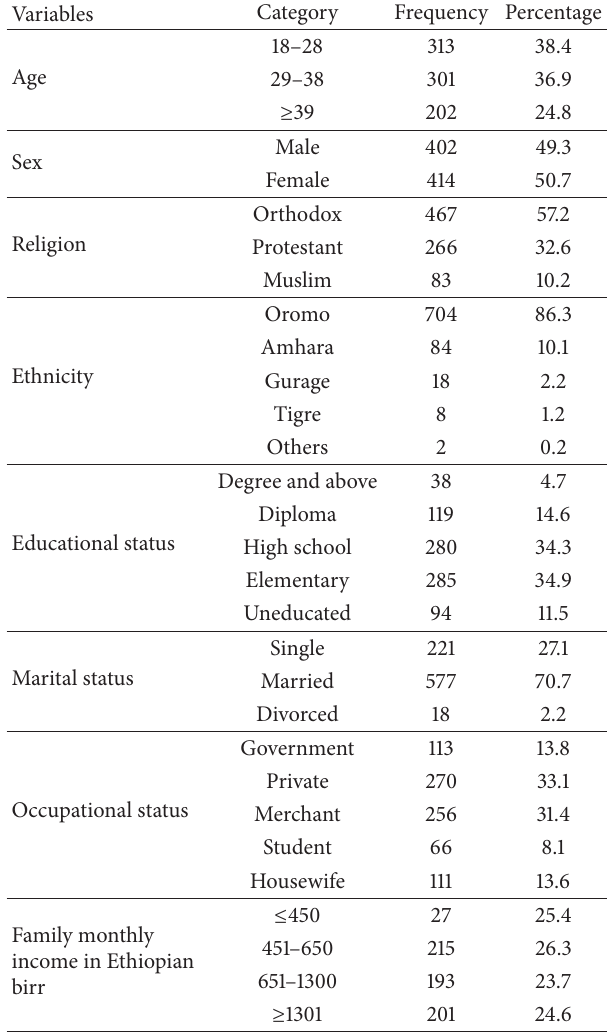
Table 1: Sociodemographic characteristics of respondents ( 𝑛 = 816